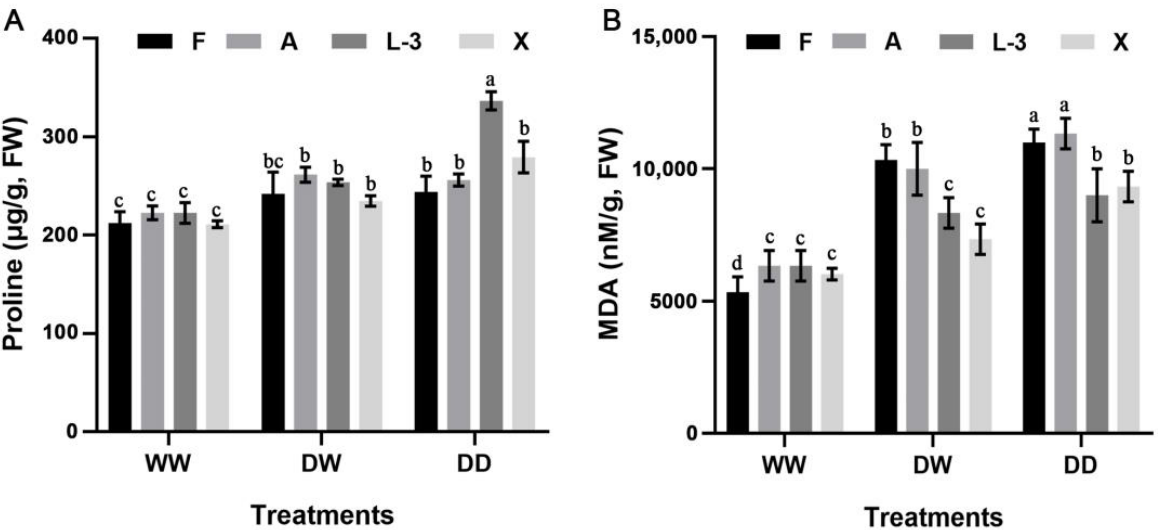
Figure 9. Determination of physiological indexes related to stress under different conditions. ( A ), proline content. ( B ), MDA content. WW, irrigation condition. DW, half-irrigation condition. DD, drought condition. F, Favorita cultivar. L-3, Longshu No.3 cultivar. A, Atlantic cultivar. X, Xindaping cultivar. Each value is the average of three replicates, and error bars represent ± SD. Different letters (a – d) represent significant differences at p < 0.05 level.